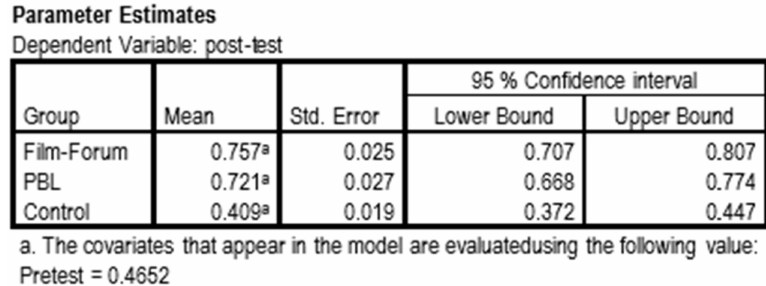
Figure 5. Knowledge measures obtained based on the